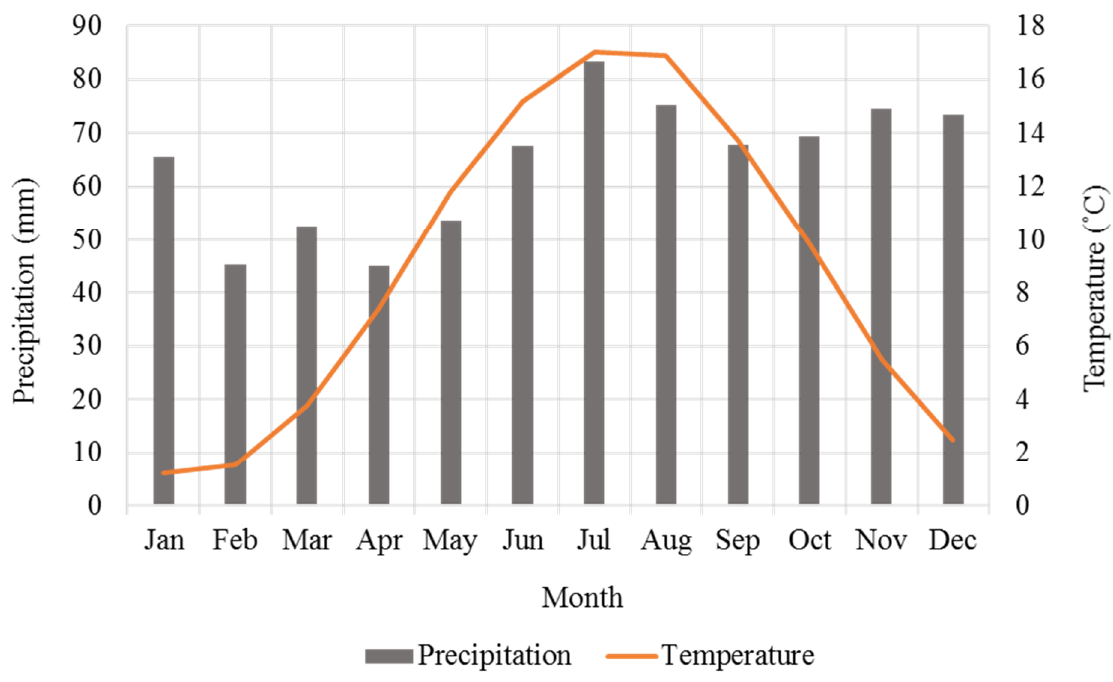
Figure 3. Average monthly precipitation and temperature in the study area (1961–2019).